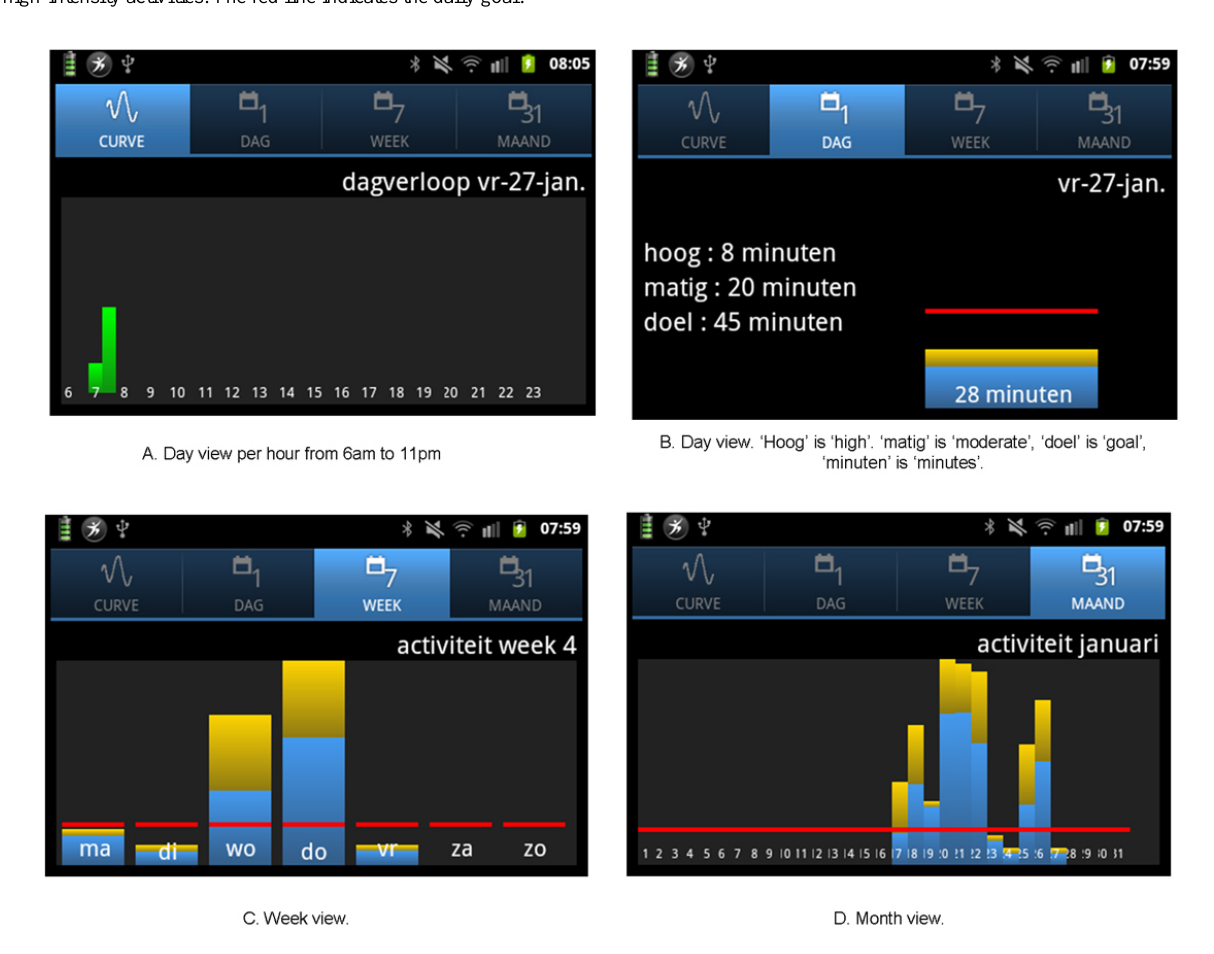
Figure 3. Activity menu on the smartphone app. The blue part of the bars indicates the moderately intense activity in minutes; the yellow part denotes the high-intensity activities. The red line indicates the daily